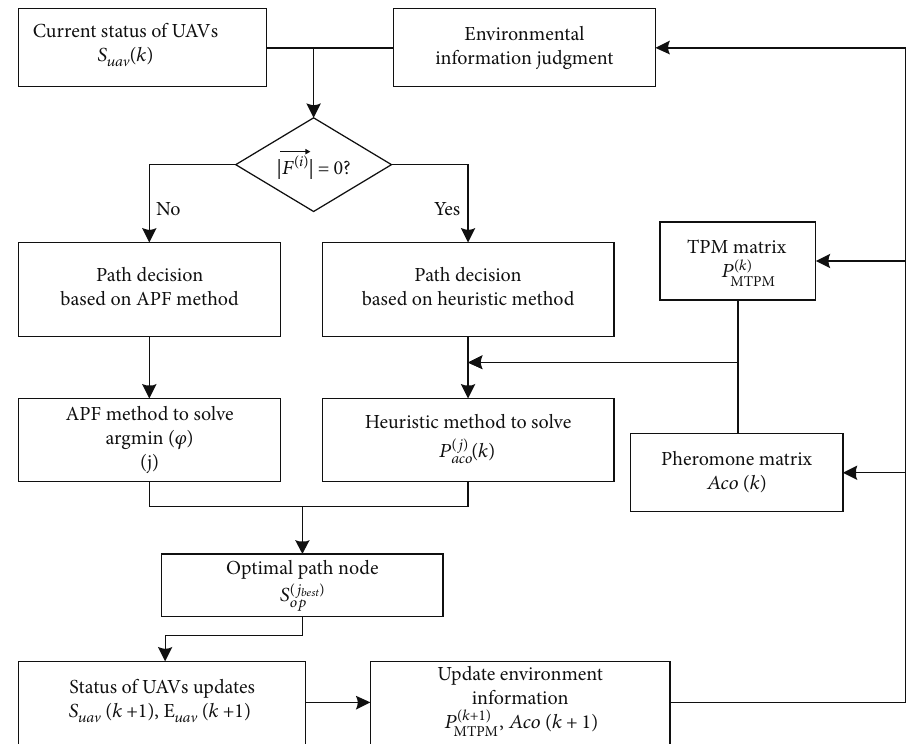
Figure 1: The block diagram of the proposed path generation and optimization method based on the